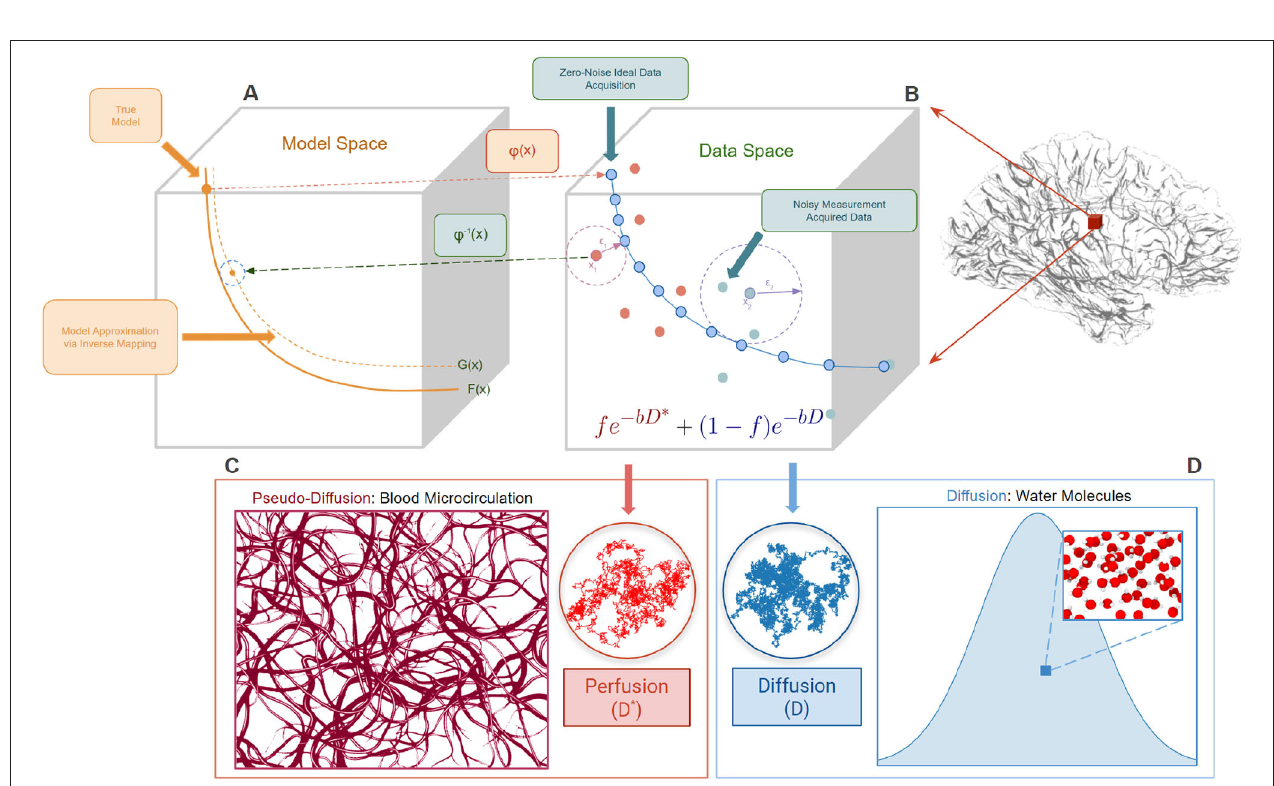
FIGURE 3 | Shows a sketch of the forward mapping ϕ ( x ) from the true model coordinates in the model space (A) to the signal measurements in the data space (B) and its inverse denoted by ϕ − 1 ( x ). (B) Notice that some signal measurements in the data space correspond more to perfusion and some correspond more to diffusion. This is a mixing phenomenon. It is important to note that the deviation from the ideal signal is due to different levels of noise ( ε ). F ( x ) represents the true model coordinates in the model-space and G ( x ) is the approximation of F ( x ) due to noisy measurements. (C) Depicts the randomly oriented capillary geometry for the perfusion process which is modeled as a “pseudo-diffusion” process ( D ∗ ). fe − bD ∗ is the compartment used to represent this random process. (D) Denotes the diffusion process of the water molecules represented by an isotropic compartment fe − bD